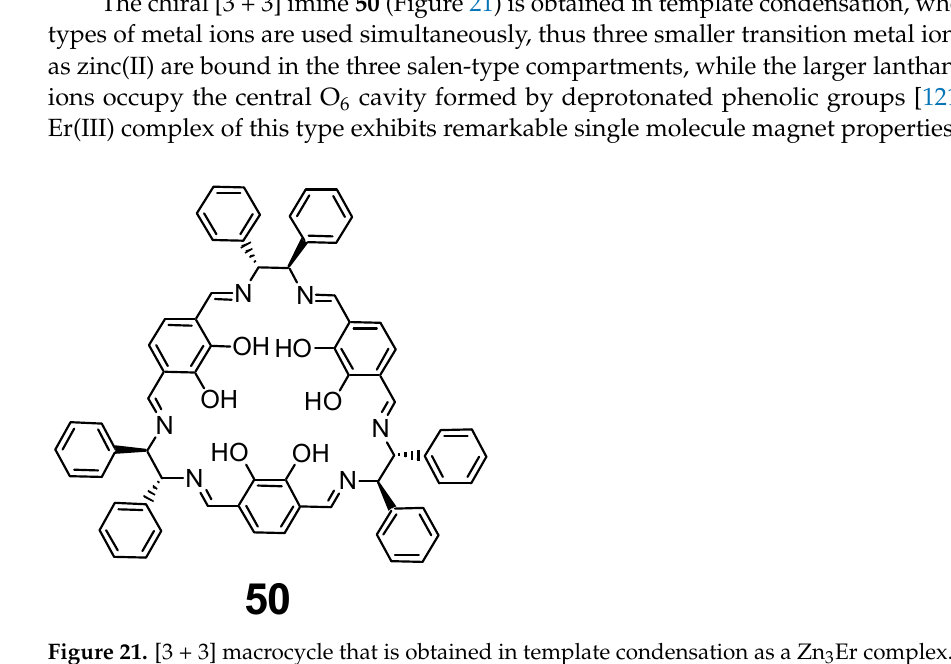
Figure 20. Amine counterparts of calixsalenes.